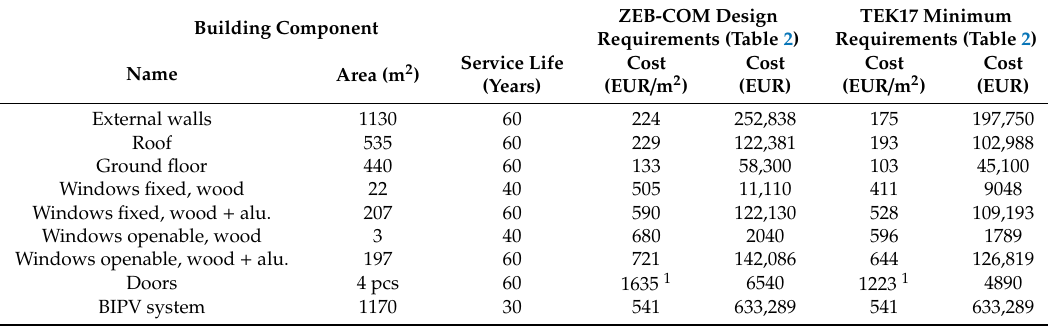
Table 7. Cost of the building components for the ZEB-COM and TEK17